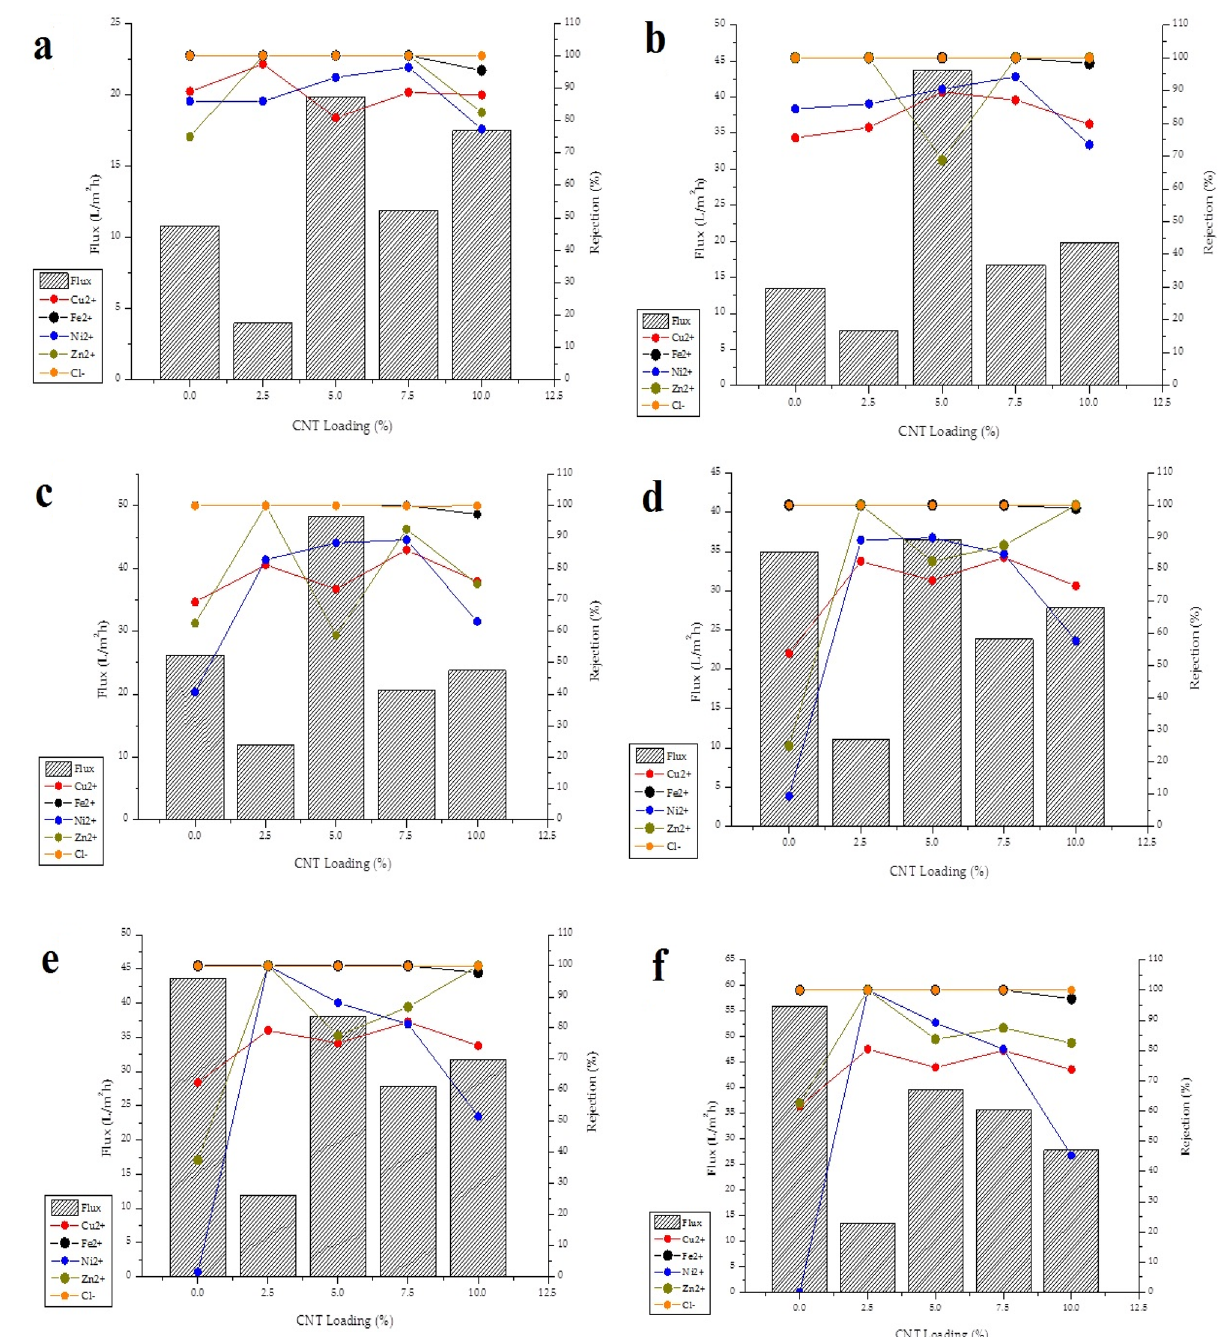
Figure 7. Membrane performance evaluation ( a ) evaluation at 100 kPa ( b ) evaluation at 300 kPa ( c ) evaluation at 500 kPa ( d ) evaluation at 700 kPa ( e ) evaluation at 900 kPa f) evaluation at 1100